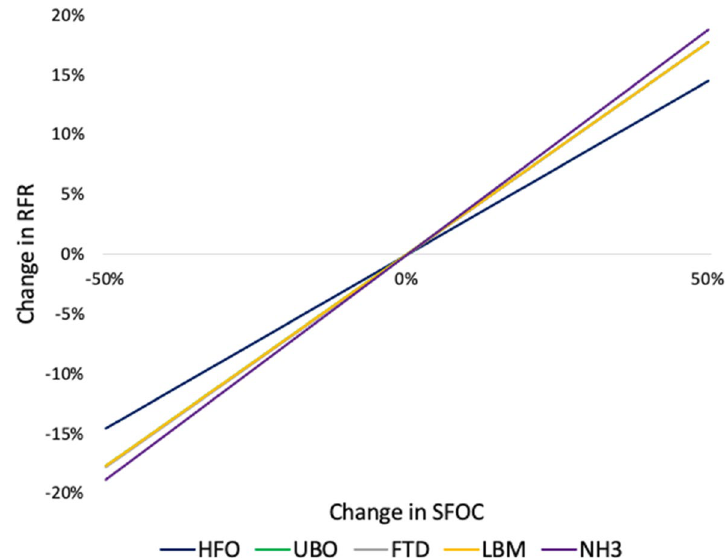
Fig. 3 Sensitivity analysis on SFOC for HFO, UBO, FTD, LBM and NH3 under the average, 2020, no regulation